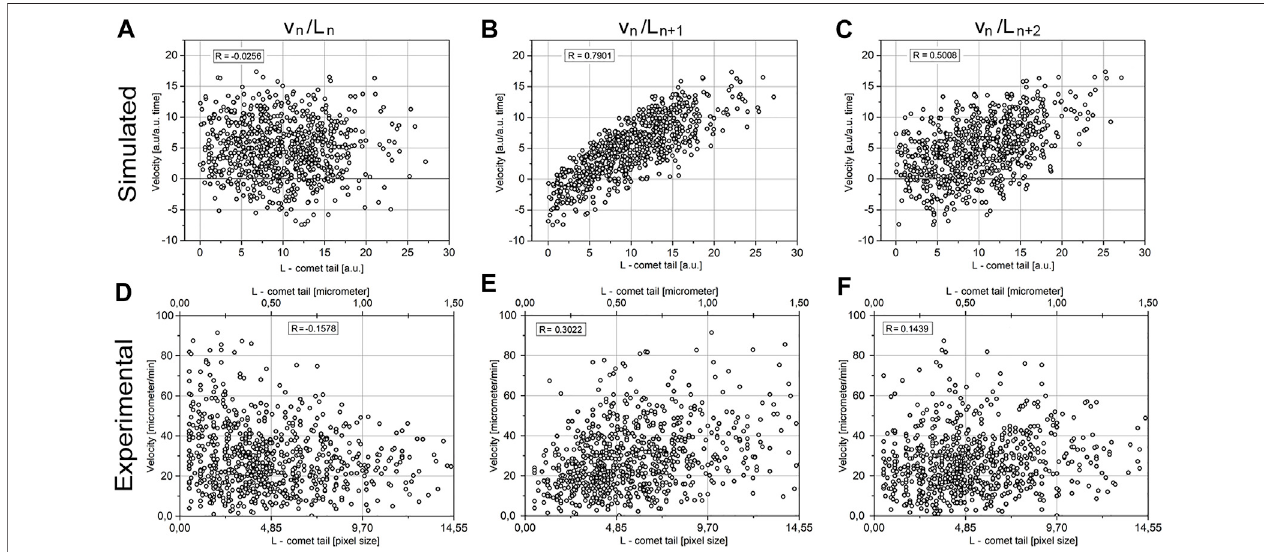
FIGURE7| Correlation betweenthevelocityofMTelongationandtaillength.Thecomparisonofthesimulatedmodeldata (A − C) andtheexperimental data (D – F) . Images (A, D) represent the correlation between v n and L n , image (B, E) represents v n /L n+1 , and (C, F) represents v n /L n+2 .